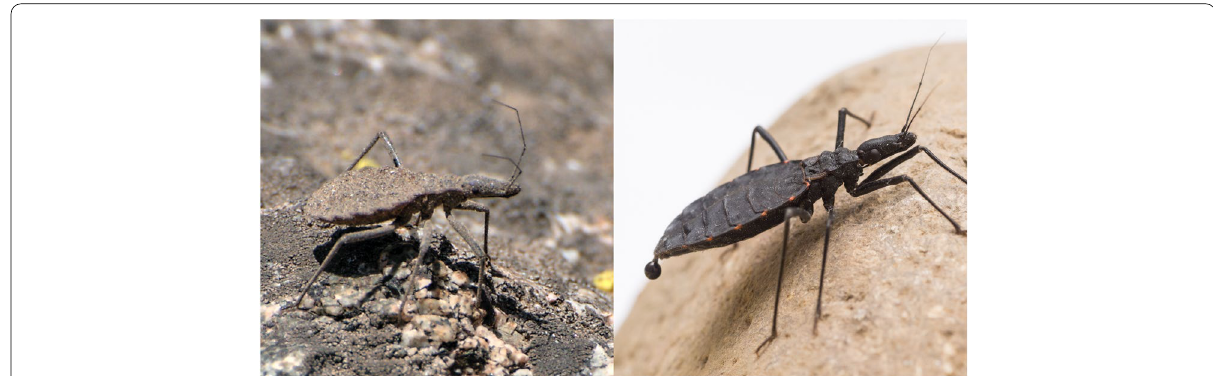
Fig. 2 Camouflaged nymph of Mepraia spinolai (left). This natural behavior is performed by small, medium, and large‑sized nymphs (0.4‑1.5 cm length) of all Mepraia species when the appropriate substrate is provided. Adult female of Mepraia gajardoi with a feces droplet (right). Defecation usually occurs during or right after a blood meal, potentially resulting in Trypanosoma cruzi transmission through self‑inoculation. Photographs by Rodrigo Medel and Vicente Valdés,